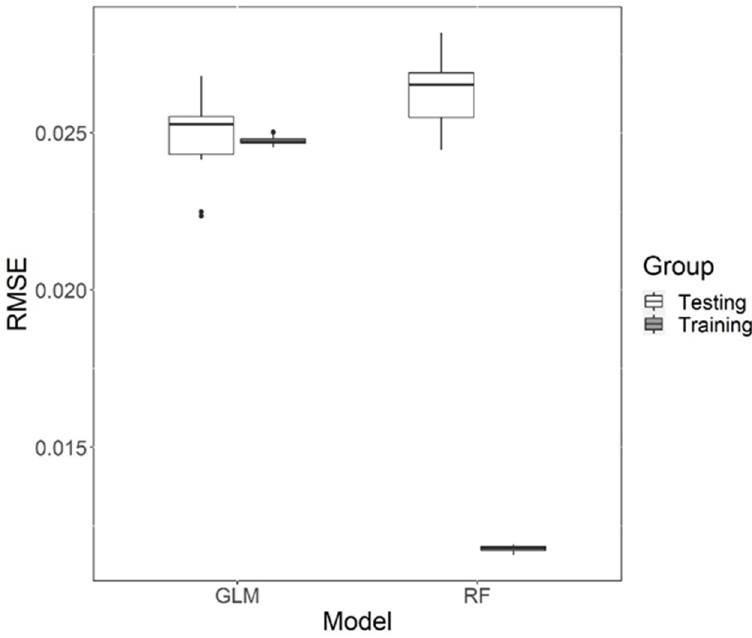
Figure 5. Performance of the General Linear Model (GLM) and Random Forest (RF) model after 10-fold cross validation in 1000 iterations. The solid line represents median Root mean square error (RMSE) while the whiskers represent maximum and minimum value within 1.5 times of inter- quartile range from the hinges. The black dots represent outliers beyond the range of whiskers. (GLM: Testing = 0.0248 ± 0.0018; Training = 0.0247 ± 0.0002; RF model: Testing = 0.0262 ± 0.0019, Training = 0.0118 ±